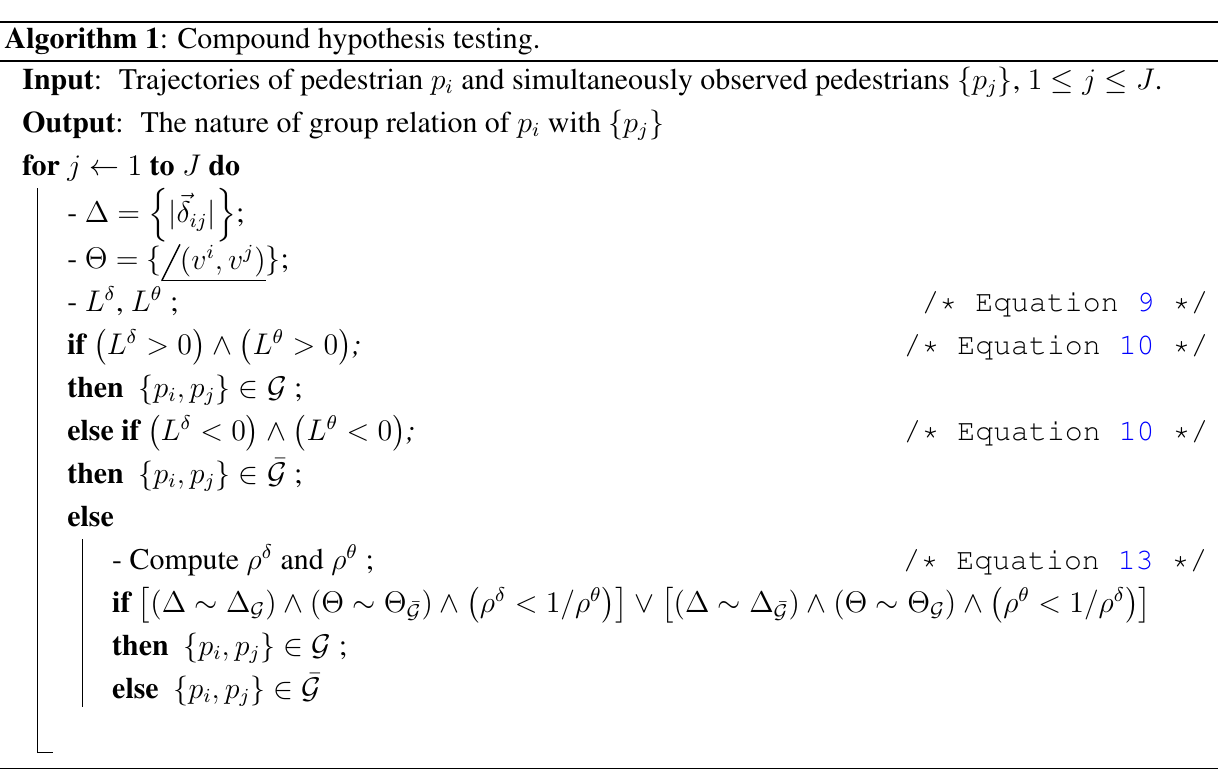
Algorithm 1 : Compound hypothesis